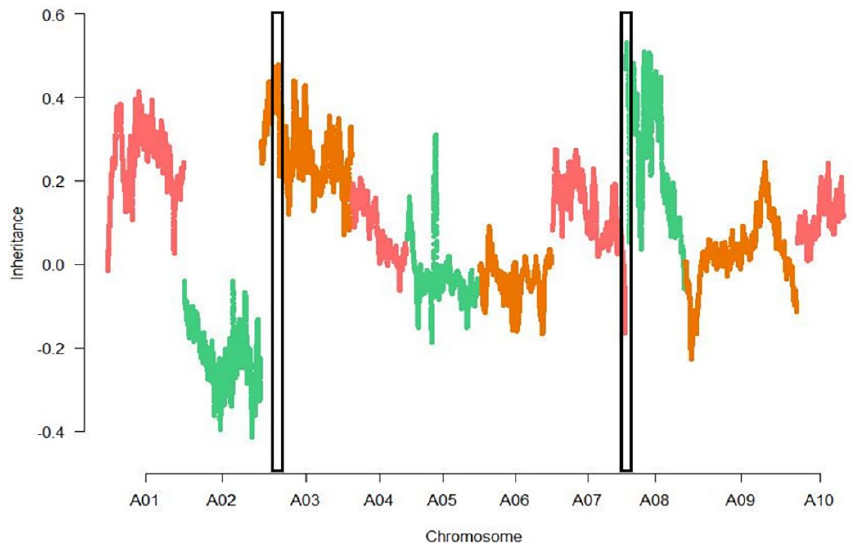
Figure 4. Genome − wide Δ SNP index Manhattan plots graph of two extreme pools. Two regions on chromosome A03 and A08 (black box) were identified.